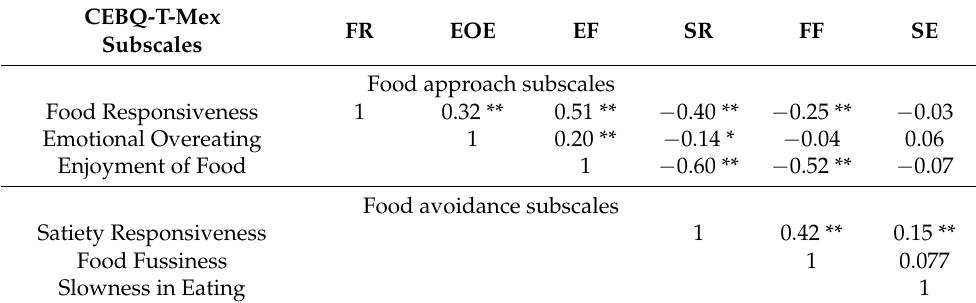
Table 6. Pearson’s correlations between appetitive trait subscales for the CEBQ-T-Mex (n =